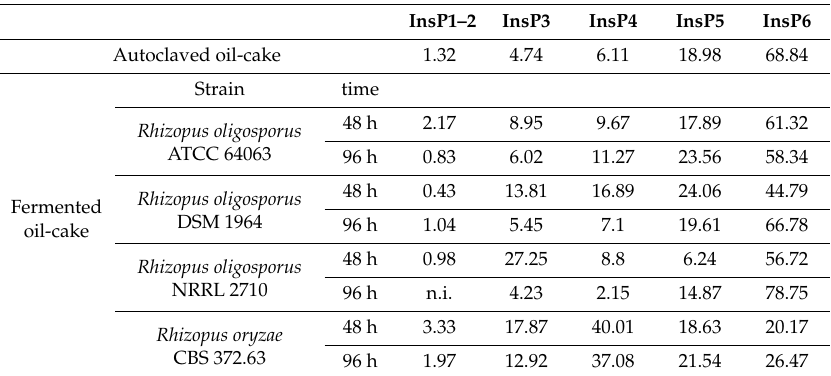
Table 2. Inositol phosphate profile (% relative peak area) of pumpkin oil-cake, autoclaved and fermented with Rhizopus strains.